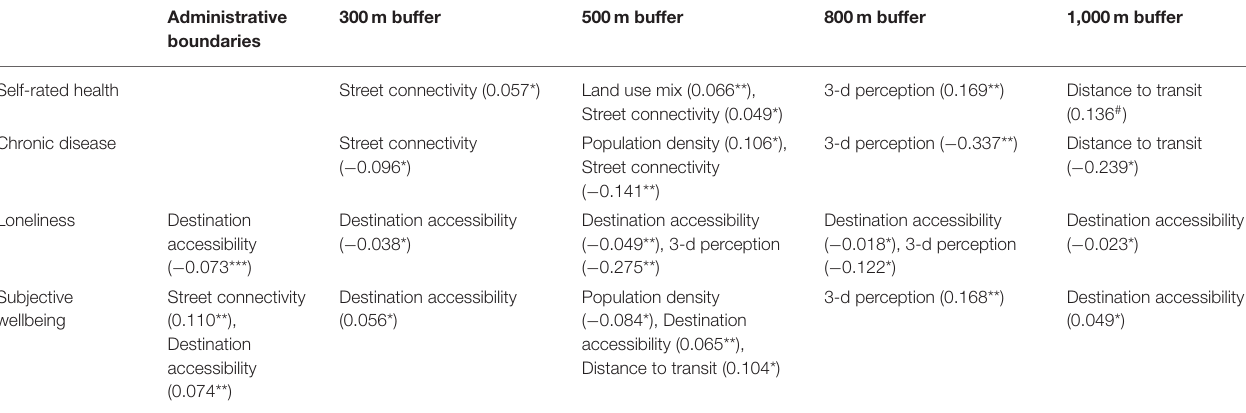
TABLE 4 | Statistical results of multilevel regression models for multi-buffer-built environment and elderly